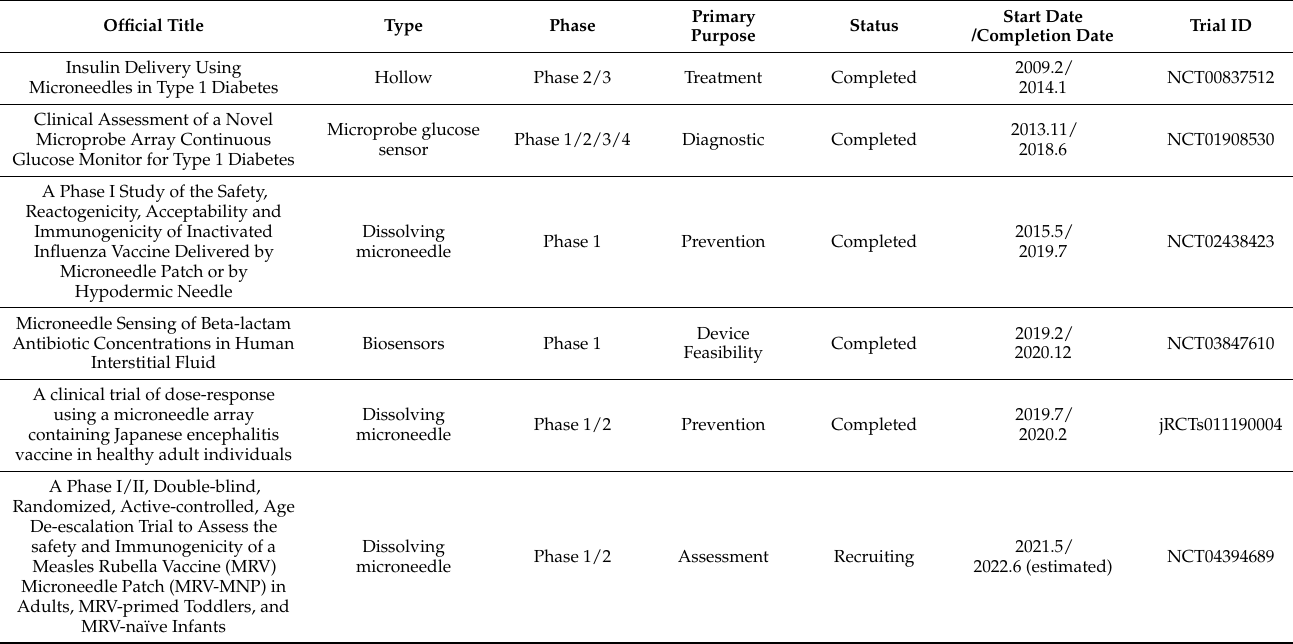
Table 3. Clinical research progress in microneedle